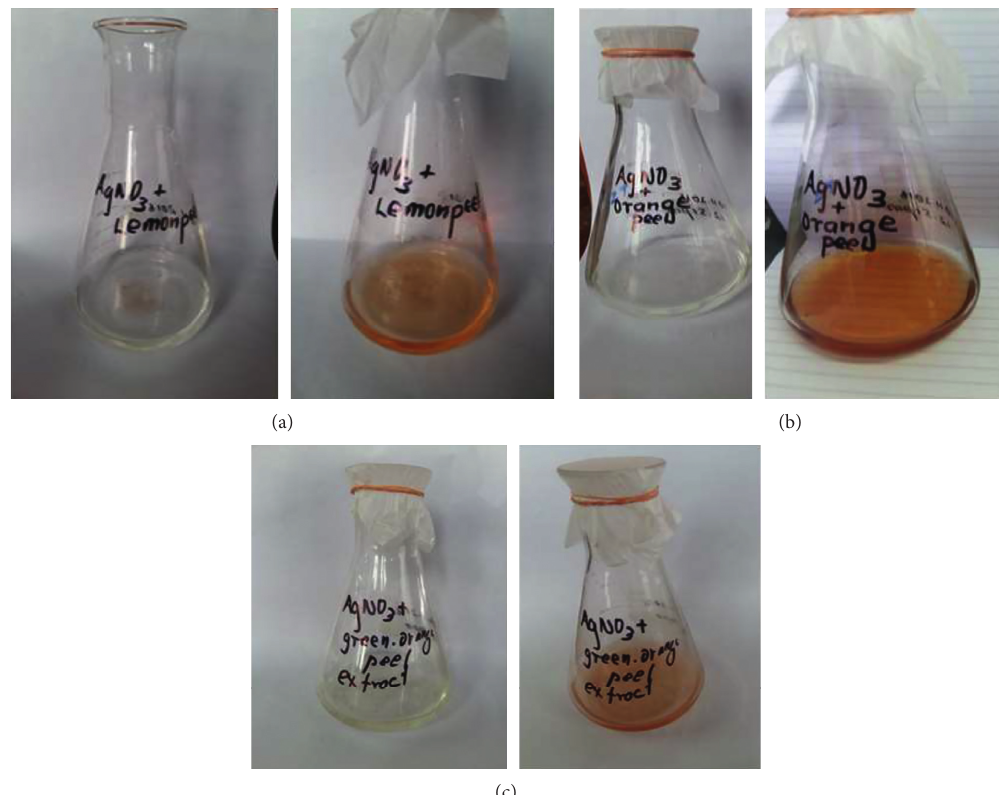
Figure 1: Colour change in the solution after the addition of (a) lemon peel extract, (b) orange peel extract, and (c) green orange peel extracts due to reduction of silver